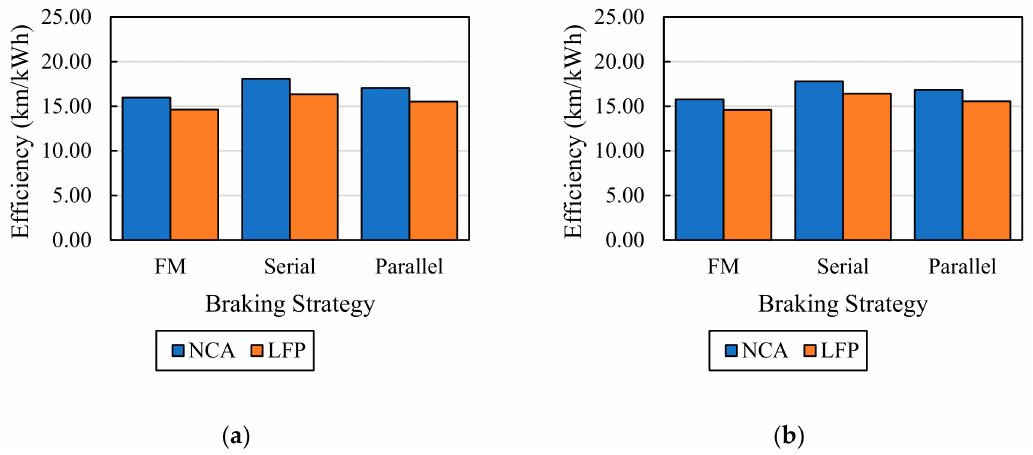
Figure 13. The e ffi ciency of non-RE configurations ( a ) first route and ( b ) complete route.